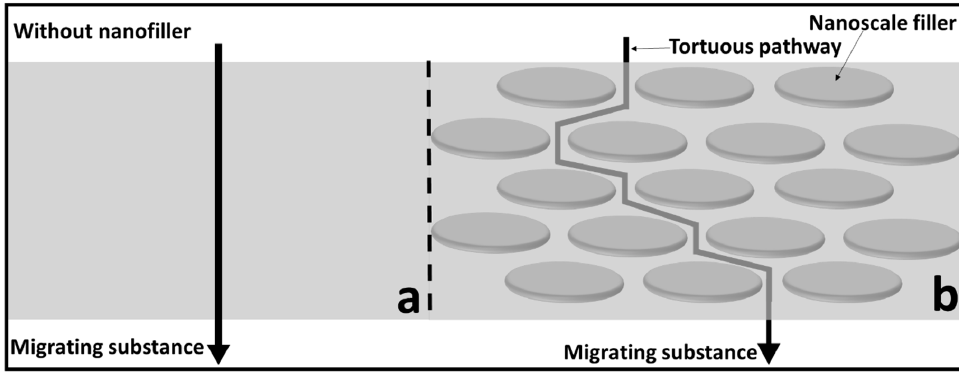
Figure 4. Schematic of the gas molecule diffusion through ( a ) a polymer-only barrier and ( b ) a polymer composite barrier. Uniformly dispersed nanoplates decrease the permeability by increasing the resistance through tortuosity. Adapted from [1,7].